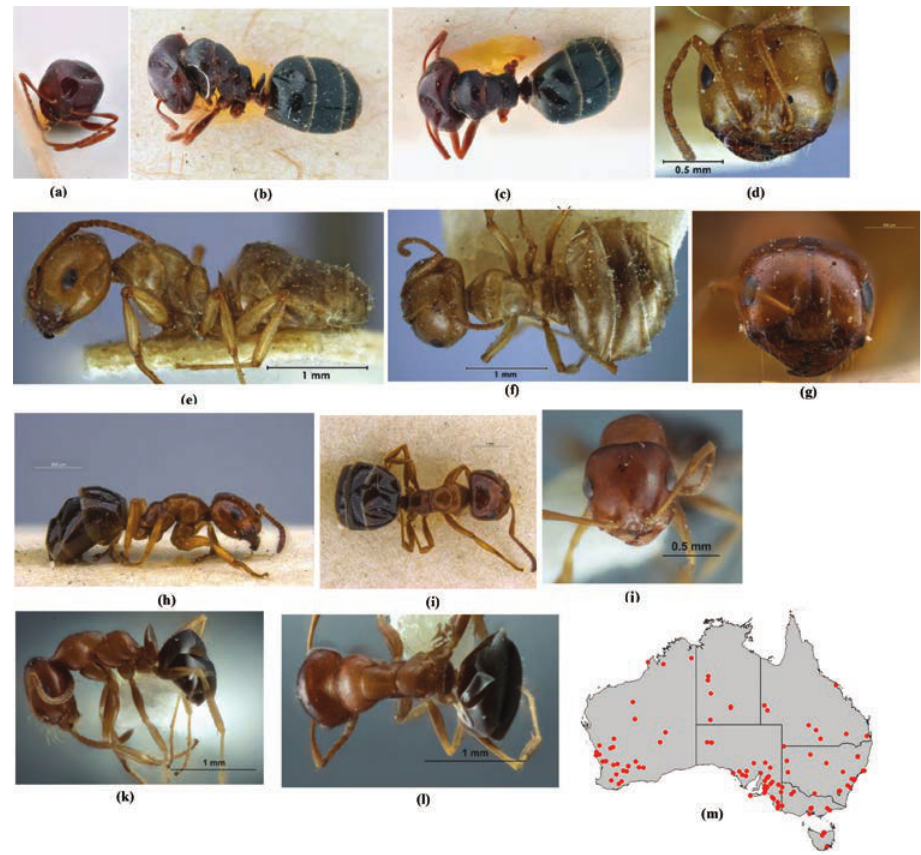
Figure 31. Melophorus biroi Forel: HNMH ‘ biroi ’ major worker holotype (probable) frons ( a ), pro- file ( b ) and dorsum ( c ); MHNG ‘ marius ’ major worker holotype frons ( d ), profile ( e ) and dorsum ( f ); ZHMB ‘ fieldi propinqua ’ major worker syntype (GBIF-D/FoCoL 2211) frons ( g ), profile ( h ) and dor- sum ( i ); non–type minor worker (ANIC ANTS Vial 1.210) frons ( j ), profile ( k ) and dorsum ( l ); distribu- tion map for the species for the species ( m ). Low resolution scale bars: 1 mm ( i ); 500µm ( g, h ); (scale bars not supplied on Automontage photographs ( a–c